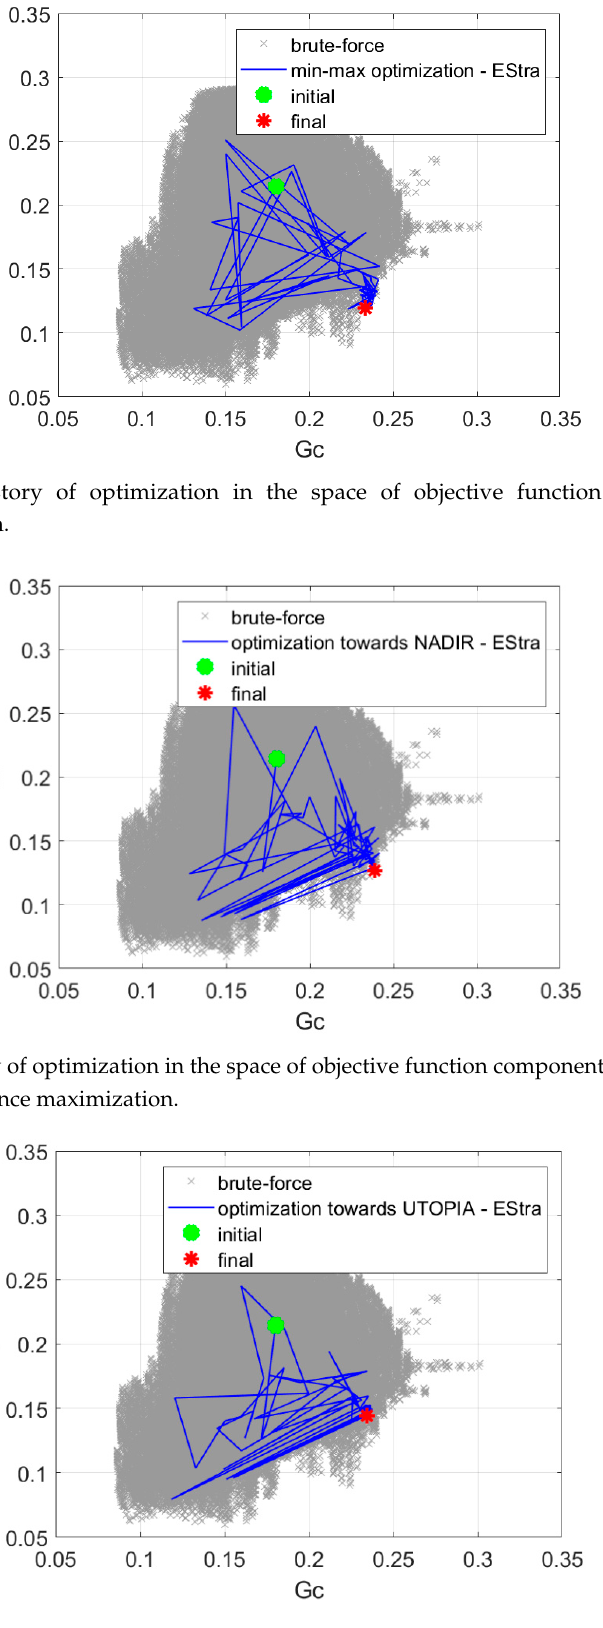
Figure 12. The history of optimization in the space of objective function components for optimization with utopia point distance minimization. with utopia point distance